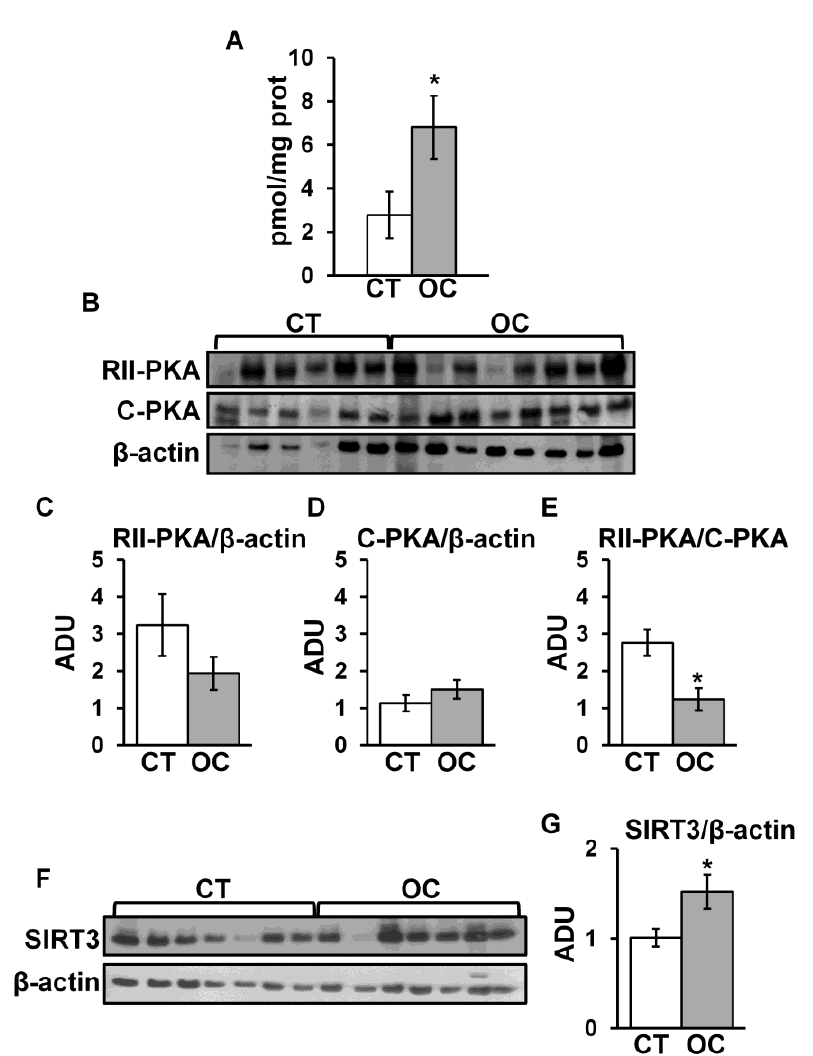
Figure 4. cAMP content, protein kinase A (PKA), and sirtuin 3 (SIRT3) protein levels in CT and OC tissues. ( A ) The specimens of control (CT) and ovarian cancer (OC) tissues were homogenized in 0.1 M HCl and centrifuged at 1000 × g ; the supernatant was used for determination of total cAMP level. The histograms represent the means of values ± SEM of samples. ( B ) The panel shows representative images of Western blotting analysis. The samples of CT and OC were homogenized in buffer A and sonicated; proteins were loaded on 8% SDS-PAGE. After separation, the proteins were transferred to nitrocellulose membranes and immunoblotted with the antibodies against the regulatory subunit of PKA (RII-PKA) and the catalytic subunit of PKA (C-PKA). Protein loading was assessed with β-actin antibody. ( C , D ) The histograms represent the means of values of ADU ± SEM of samples. ( E ) The histograms represent the means of values ± SEM of the RII-PKA/C-PKA ratio. For RII-PKA and C-PKA, 12 CT and 10 OC samples were analyzed. ( F ) Representative images of Western blotting analysis with antibody against SIRT3. Protein loading was assessed with β-actin antibody. ( G ) The histograms represent the means of values of ADU ± SEM of samples. For SIRT3, 14 CT and 16 OC samples were analyzed (* p < 0.05, Student’s t -test). For other details, see Section 4.